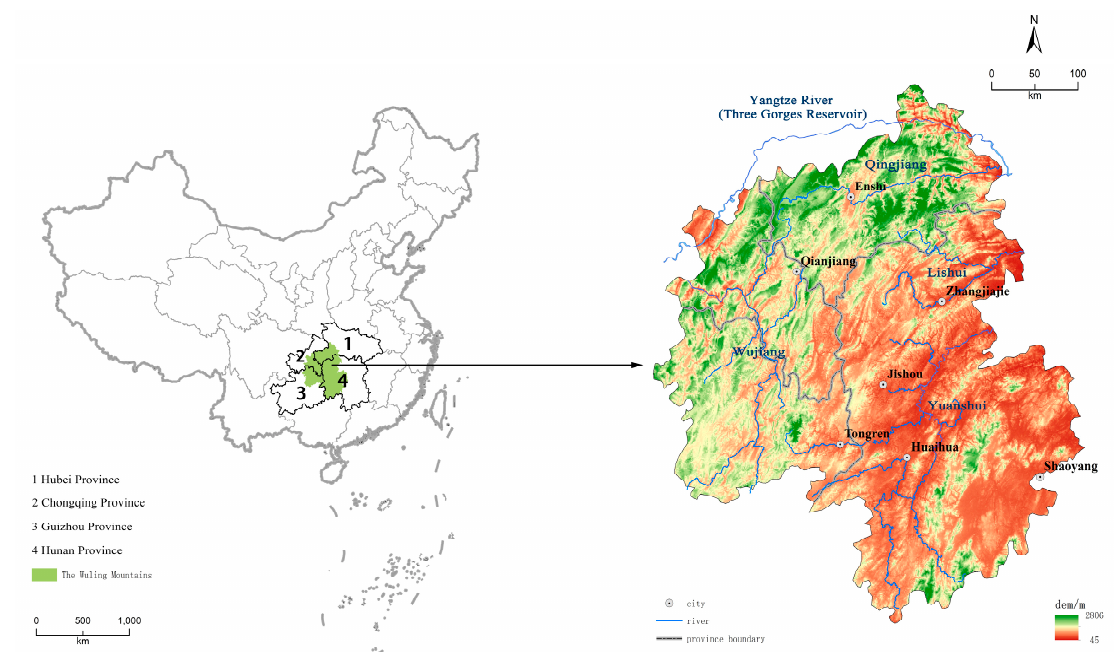
Figure 1. Location of the Wuling Mountains.